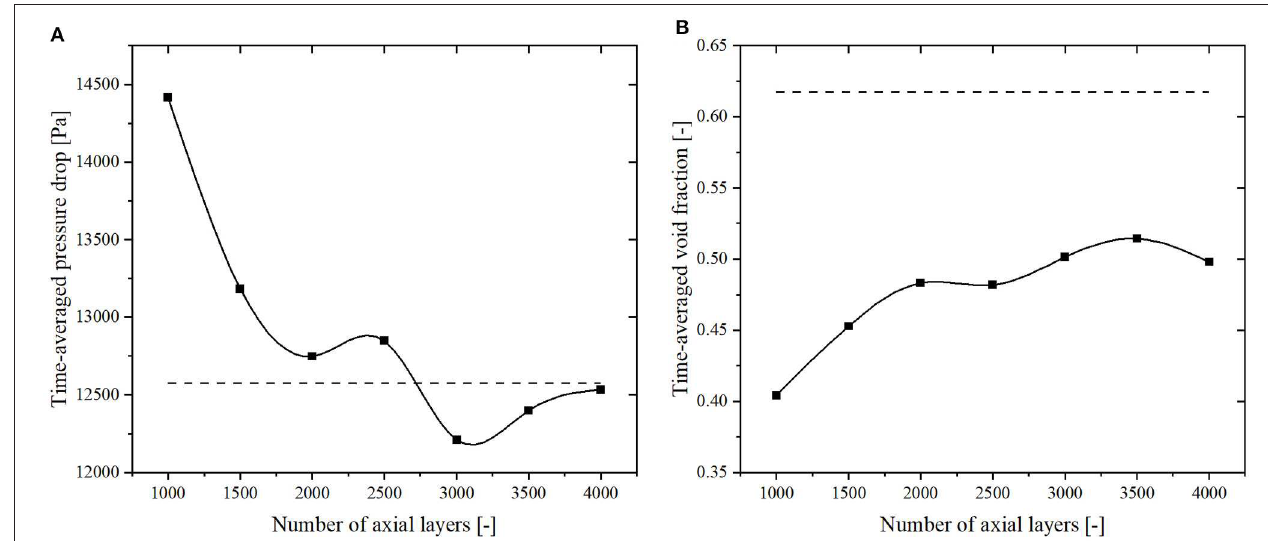
FIGURE 3 | Results of the mesh convergence study. (A) Two-phase pressure drop. (B) Void fraction.